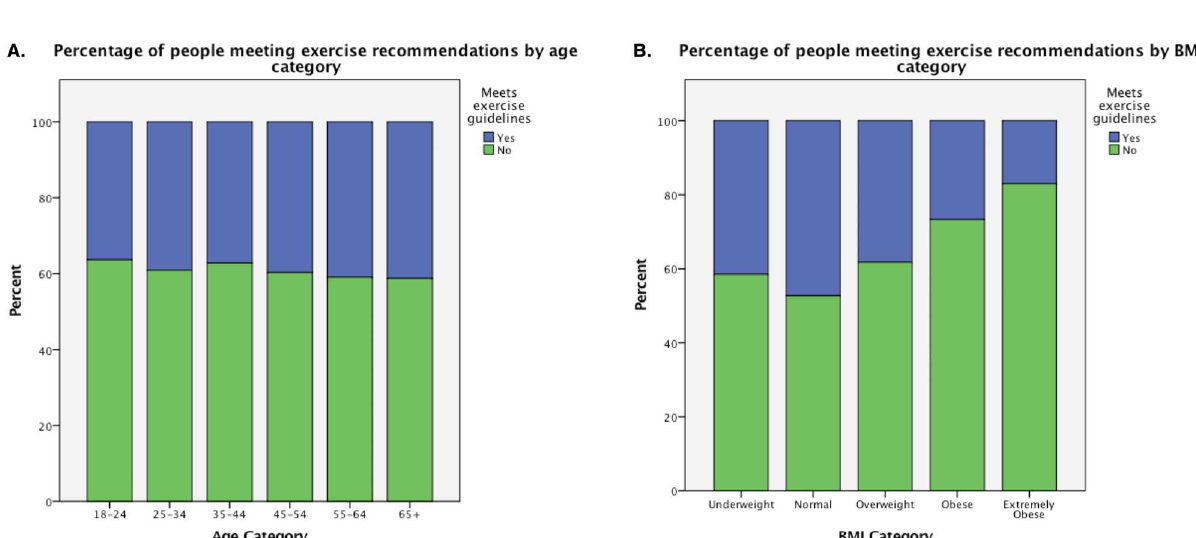
PLOS ONE | https://doi.org/10.1371/journal.pone.0173603 April 12,